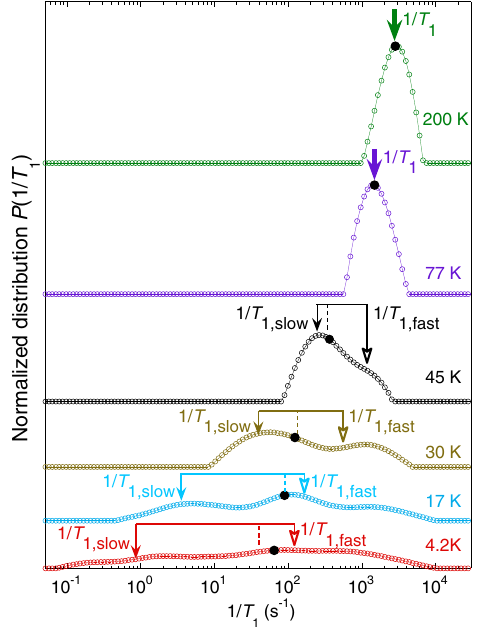
FIG. 8. Distribution function P ð 1 =T 1 Þ of 1 =T 1 at representative temperatures directly computed from the recovery data M ð t Þ based on the inverse Laplace transform [41]. For clarity, the origin is shifted vertically except for 4.2 K. P ð 1 =T 1 Þ is centered around a single value of 1 =T 1 above 60 K; the peak location at 77 and 200 K agrees very well with 1 =T 1 estimated from the single- component fit with Eq. (A1), as marked by thick arrows. This one peak distribution of P ð 1 =T 1 Þ breaks down at lower temperatures. The filled and open arrows at and below 45 K mark 1 =T 1 ; slow and 1 =T 1 ; obtained from the two-component fit with Eq. (A3), fast estimated from respectively. The dashed lines mark 1 =T 1 ; str Eq. (A2), which keeps track of the center of gravity of P ð 1 =T 1 Þ marked by black filled